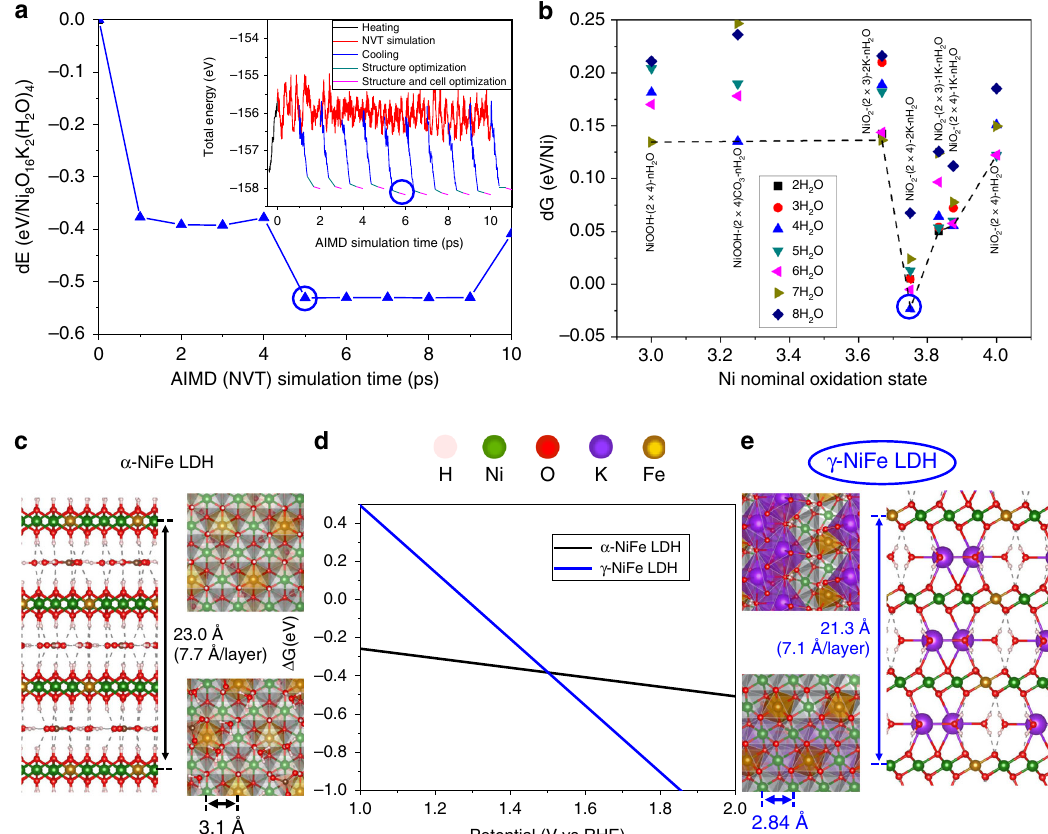
Fig. 3 Screening process, structures, and stability (phase diagram) of NiFe LDH. a The relative energy of γ -NiOOH (Ni 8 O 16 K 2 ·4H 2 O) at each picosecond of the AIMD simulation, which is used to screen the most stable con fi guration (at the 5th ps) of this speci fi c stoichiometry. The inset is the energy evolution during the entire AIMD simulation. b Free energy of formation of a series of possible γ -NiOOH structures with various amounts of water and ions intercalated between the NiOOH or NiO 2 layers. Each point is based on the most stable con fi guration of an AIMD simulation. For example, NiO 2 -(2 × 4) − 2K-4H fi guration of γ -NiFe LDH. c Side, top, and 2 O is from the 5th ps simulation of Ni 8 O 16 K 2 ·4H 2 O in A, which is then used to study the possible con bottom views of the α -NiFe LDH; d stability of α - and γ -NiFe LDH; e side, top, and bottom views of the γ -NiFe LDH. The structural parameters of α - and γ -NiFe LDH are also